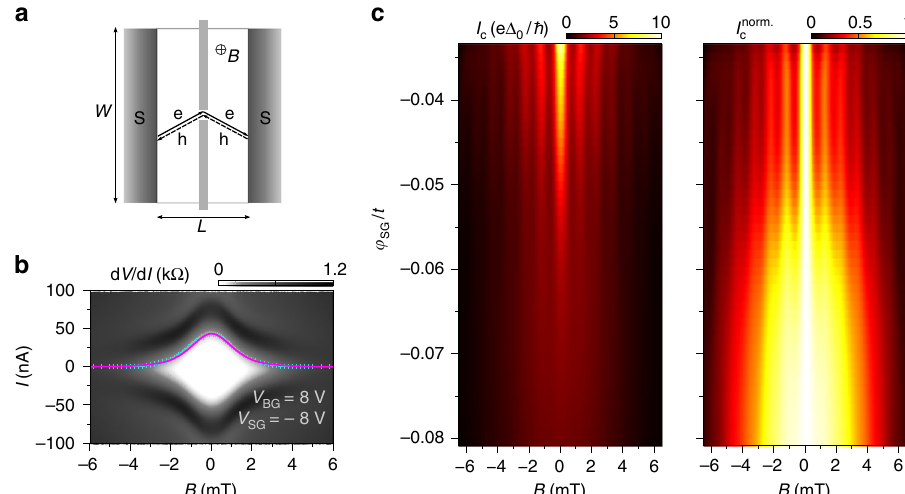
Fig. 5 Modelling supercurrent con fi nement. a Schematic of the superconducting weak link with a quantum point contact like geometry used for our analytical model. b Differential resistance d V /d I versus magnetic fi eld B and current I including the extracted critical current I c (turquoise crosses) fi tted with our analytical model (magenta line) when the 1D constriction is formed (at V BG = 8 V and V SG = − 8 V). c Numerical simulations of critical current amplitude I c (left panel) and normalised critical current amplitude I norm : (right panel) mapped as a function of magnetic fi eld B and split-gate strength φ SG c showing the transition from 2D to 1D of the magnetic interferences. The x -axis is rescaled to magnetic fi eld B using the parameters extracted by fi tting the numerical simulation to the experimental data at V SG = 0 (see Supplementary Note 7, Supplementary Figs. 8 and 9, Supplementary Note 8, Supplementary Figs. 10 and 11 for details)